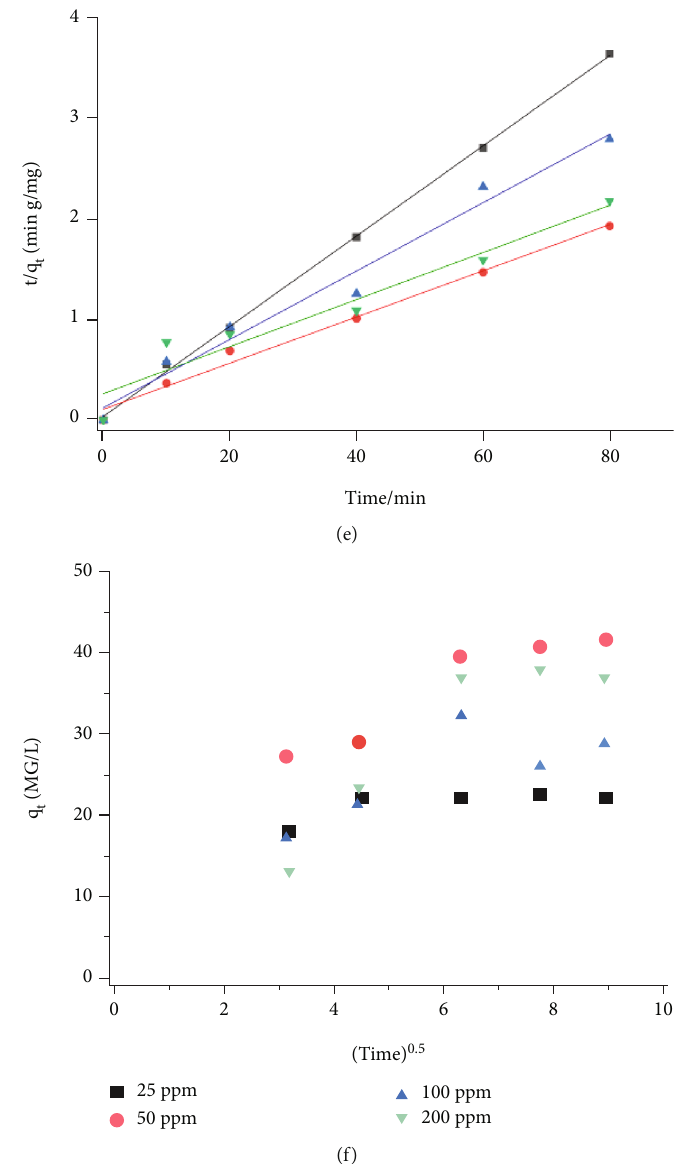
Figure 8: (a) Pseudo- fi rst-order kinetics, (b) pseudo-second-order kinetics, and (c) intraparticle di ff usion kinetics for adsorption of MB on Asp-MSNs. (d) Pseudo- fi rst-order kinetics, (e) pseudo-second-order kinetics, and (f) intraparticle di ff usion kinetics for adsorption of MB on Gly-MSNs ( m =10mg, V =10mL, pH =7, and T